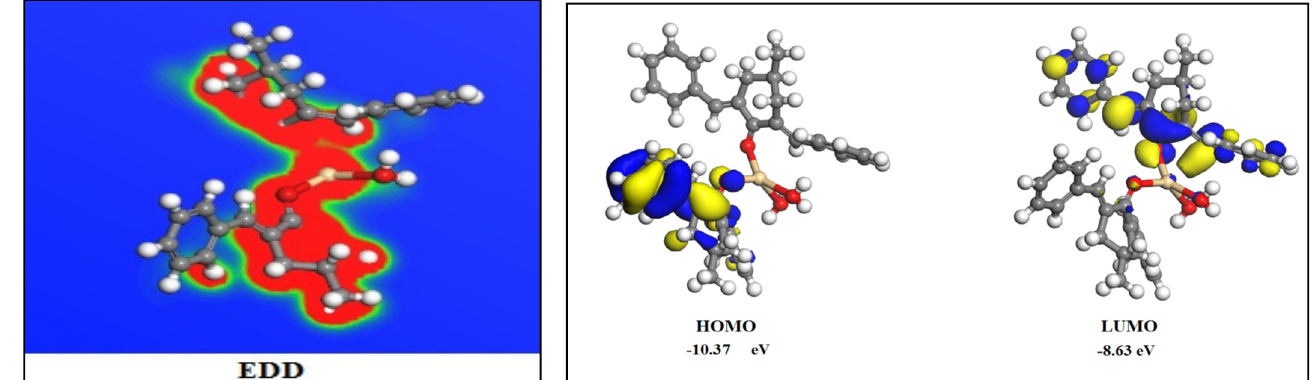
Figure 9. EDD map and the HOMO–LUMO orbitals of the cadmium complex. Table 2. Binding energies of CM1 and its Cd 2+ complex.